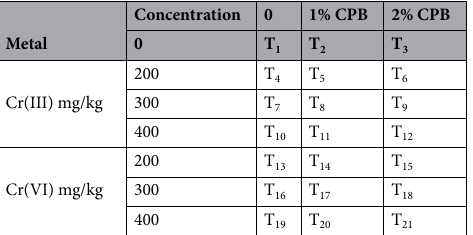
Table 2. Treatments of the experiment for assessing the effect of plant biomass of Cloncurry buffel grass (CPB) in alleviating Cr toxicity in tomato plants.